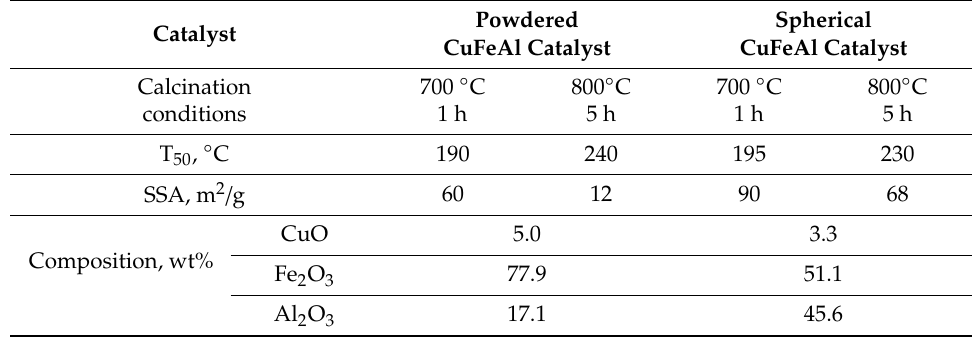
Table 4. Catalytic and physico-chemical properties of CuFeAl catalysts calcined at di ff erent